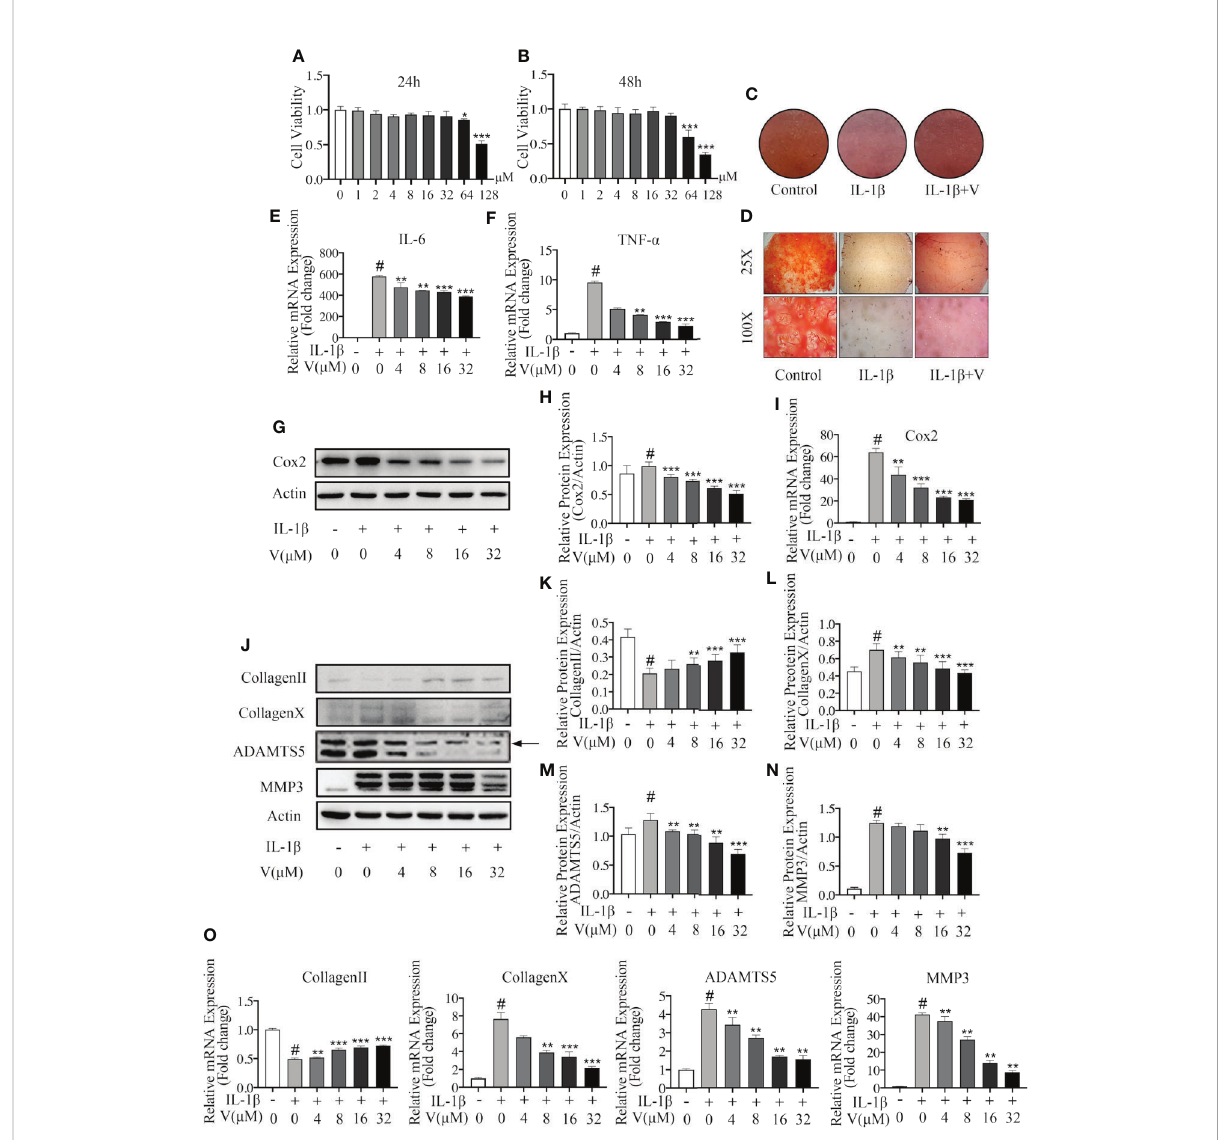
FIGURE 3 Velutin protects against IL-1 b – induced chondrocyte in fl ammation and extracellular matrix degradation in vitro . (A, B) CCK-8 experiments revealing the cytotoxic effect of velutin on chondrocytes during 24 and 48 h at various doses (n = 5). (C) Safranin O staining in high-cell density culture of primary mouse chondrocytes. (D) Safranin O staining in human cartilage tissues. (E, F) qPCR of the mRNA expression levels of TNF- a and IL-6. (G – I) Velutin inhibited IL-1 b -induced protein and mRNA expression of COX-2 in chondrocytes in a dose-dependent manner, according to Western blot and qPCR analysis. (J – O) Western blot and qPCR analyses showing that IL-1 b treatment induced collagen II degradation and increased the expression of collagen X, MMP3, and ADAMTS5, whereas velutin treatment rescued these effects. Expression of target genes was normalized to b - actin and expressed as fold change in comparison to the controls group (n = 3). Data are presented as mean ± SD; # P < 0.01 vs. control group; * P < 0.05, ** P < 0.01, *** P < 0.01 vs. IL-1 b alone (n =